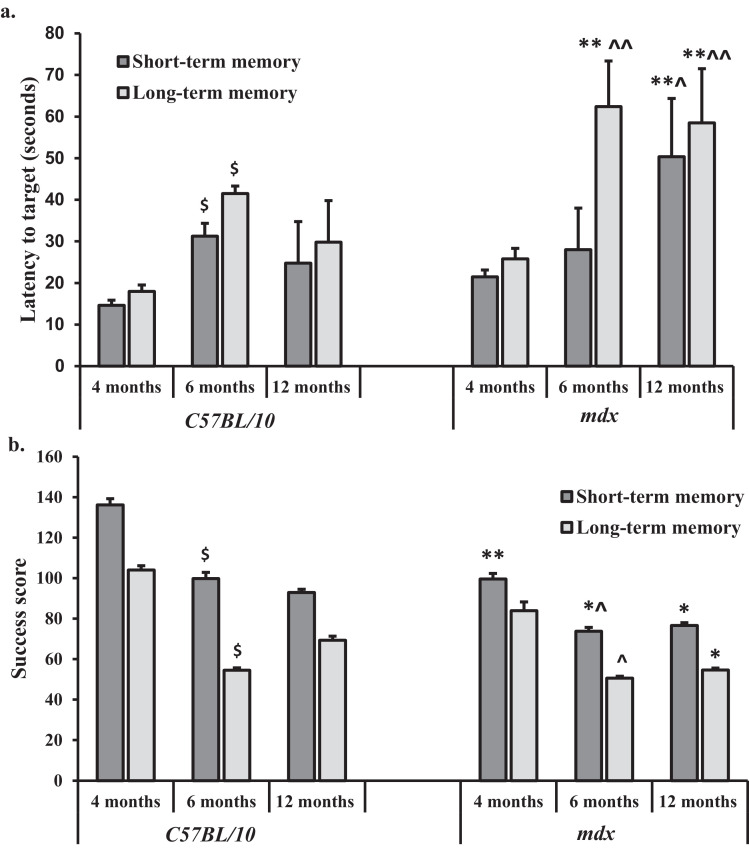
a,b: Latency to find the target hole (TH) and the success scores during Barnes maze testing. a. Short-term and long-term memory retention on the Barnes maze test. Short-term memory and long-term memory were assessed on day five and day twelve, respectively. A single trial was given to each mouse on the Barnes maze and the primary and total errors and latency(s) were evaluated as in the acquisition phase. b. Success score (hole value multiplied by the number of head pokes) observed during short and long-term memory retention trials. The highest success scores are observed during the short-term memory retention trials across all genotypes. The mdx mice had the lowest success score, at all-time points, for both short and long-term memory compared to aged matched control mice. Data presented as mean ± SEM, *p < 0.05, **p < 0.01 for control vs. mdx, ^p < 0.05, ^^p < 0.01 for changes observed with ageing in mdx mice, $<p.0.05 for changes observed with ageing in control mice.